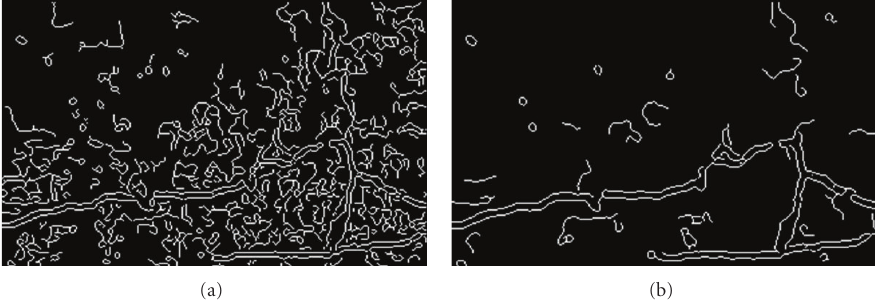
Figure 7: Crack detection using the Canny edge detector (as implemented in the Matlab Image Processing Toobox, [8]), with di ff erent parameters: (a) threshold parameter = 0.1, Gaussian smoothing parameter = 1.0; (2) threshold parameter = 0.2, Gaussian smoothing parameter = 1.5.